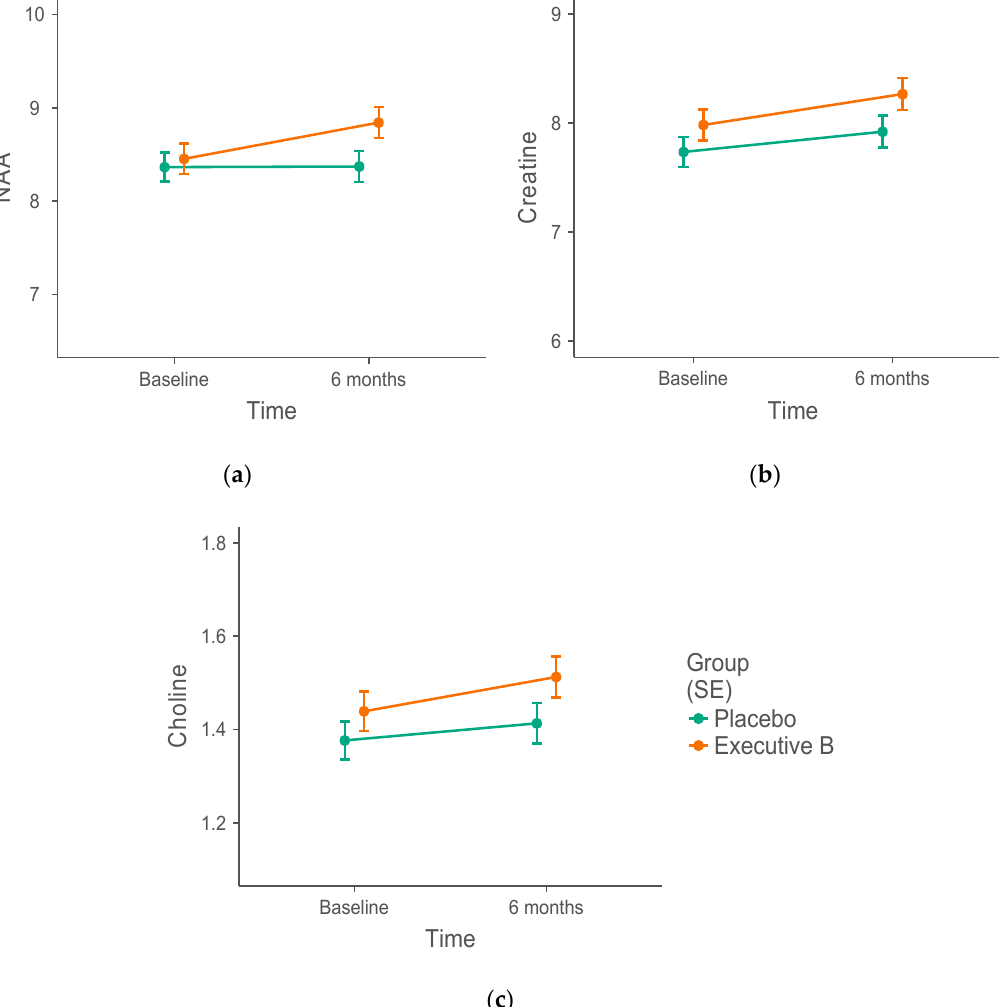
Figure 1. N -acetylaspartate (NAA), choline, and creatine concentrations in the posterior cingulate cortex (PCC). Effect of 6-month high-dose B vitamin multivitamin (Executive B) supplementation on ( a ) NAA, ( b ) creatine, and ( c ) choline concentrations in the PCC. Despite visual differences between the Executive B active and placebo intervention groups, the treatment group by time interaction was not significant (NAA: b = 0.10, 95% CI [ − 0.04, 0.24], p = 0.194).